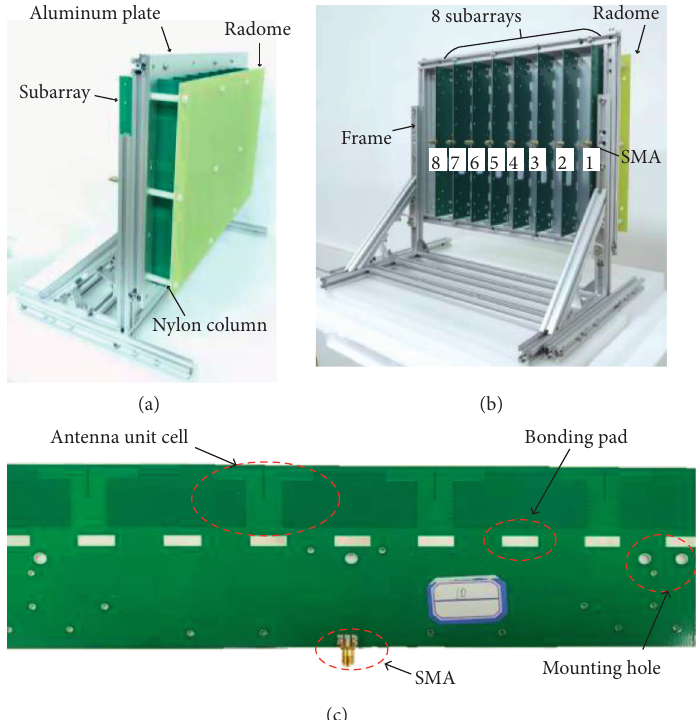
Figure 9: Photographs of the fabricated array containing the frame. (a) Front view. (b) Back view. (c) Antenna subarray.